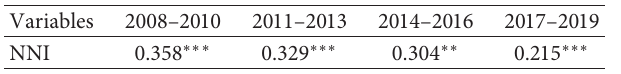
Table 2: Nearest neighbor index of high-tech enterprises identified in Nanjing.